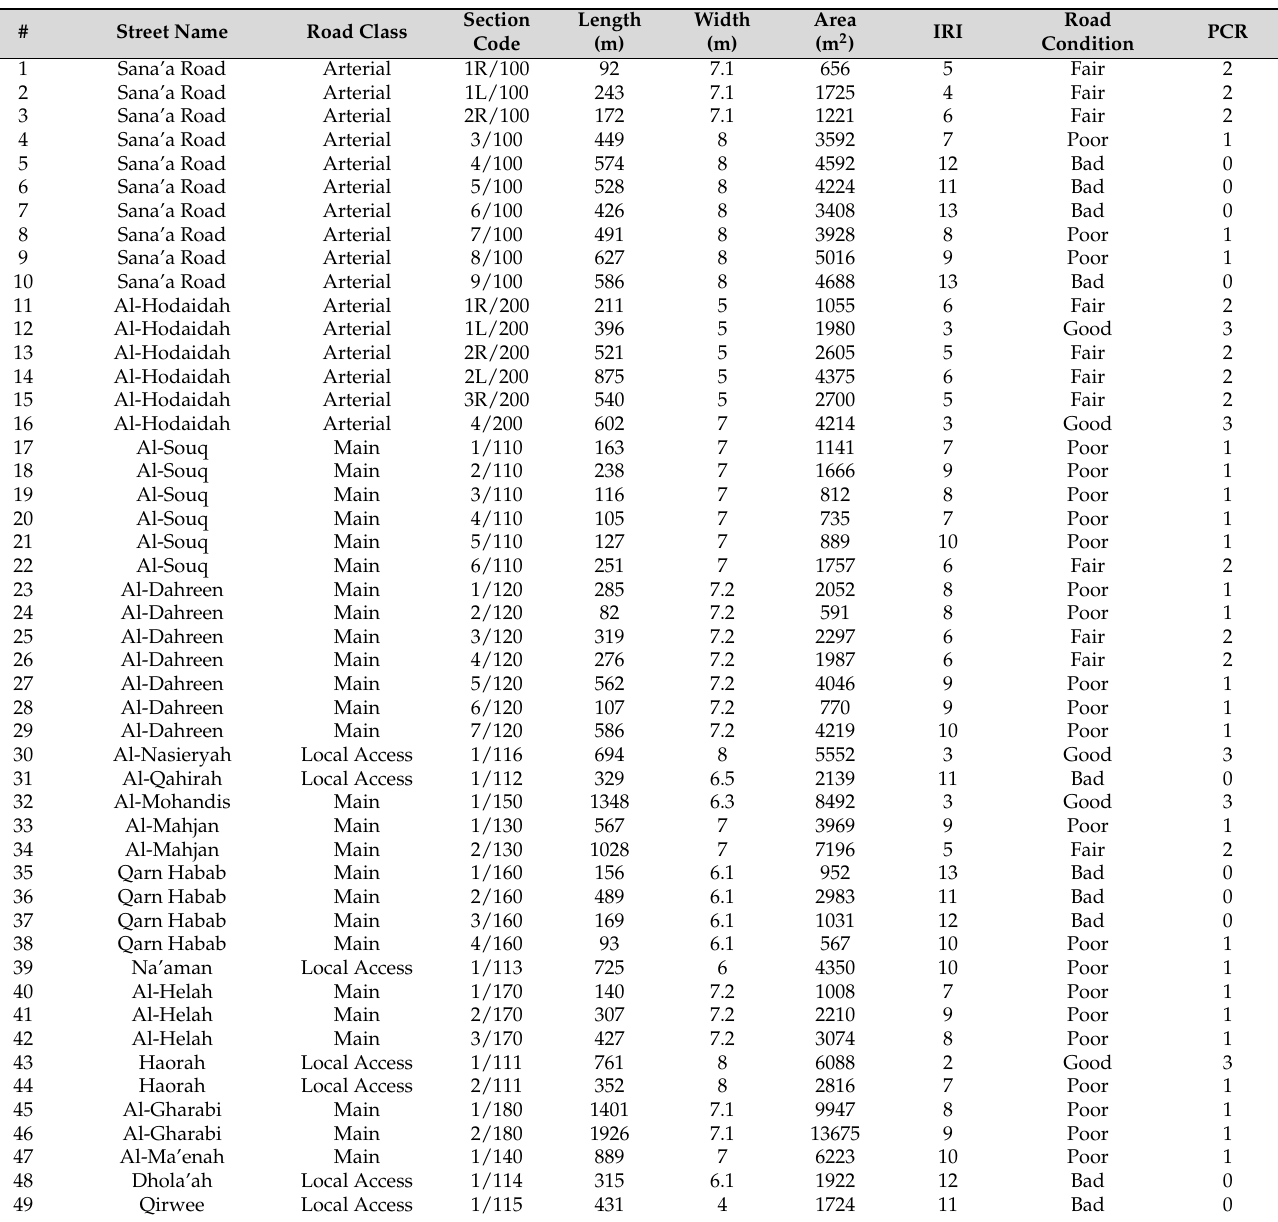
Table 3. Road sections condition